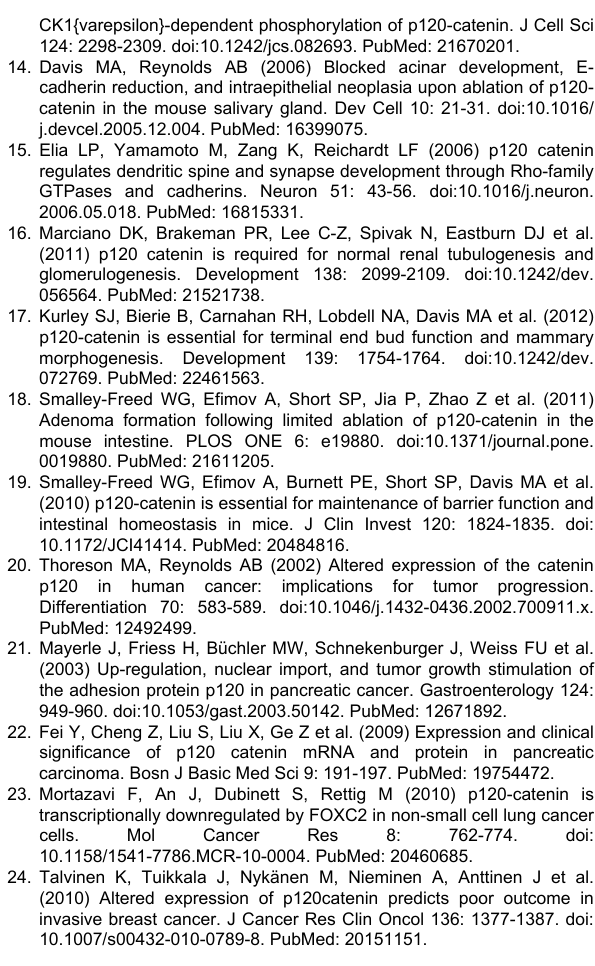
Figure S2. Transcriptomic analysis of w 1118 and w 1118 ; p120 308 flies. (A) Expression profile ( log2 expression values)